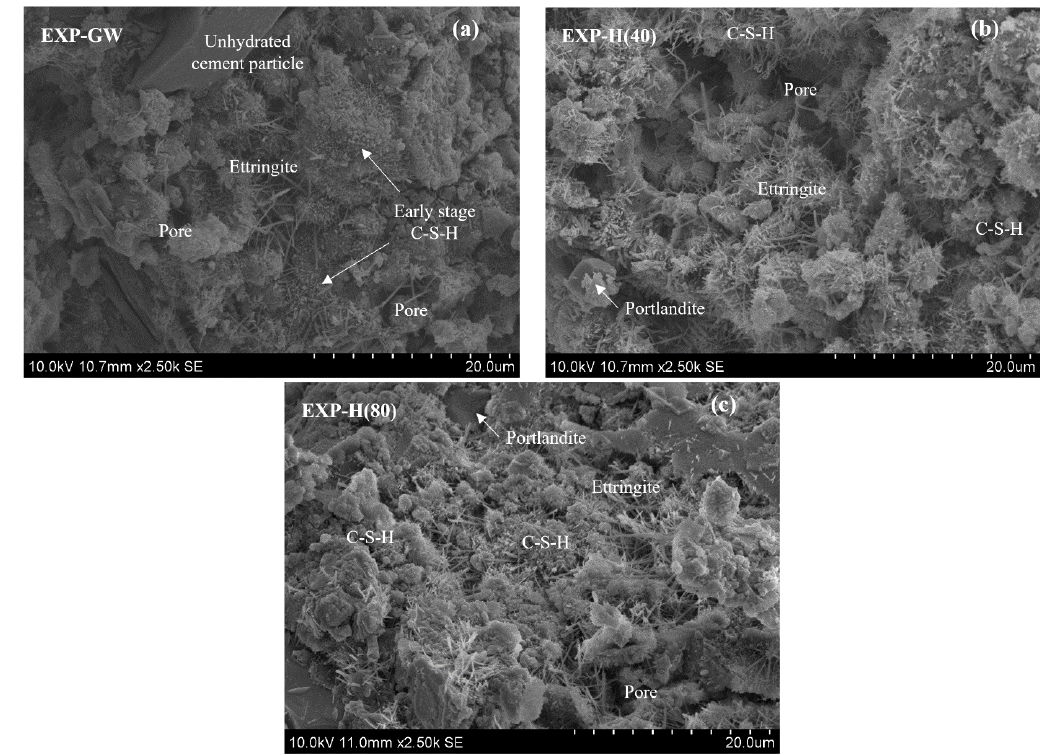
Figure 8. SEM images of cement paste after 7 days of curing: ( a ) EXP-GW; ( b ) EXP-H(40); ( c ) EXP-H(80).